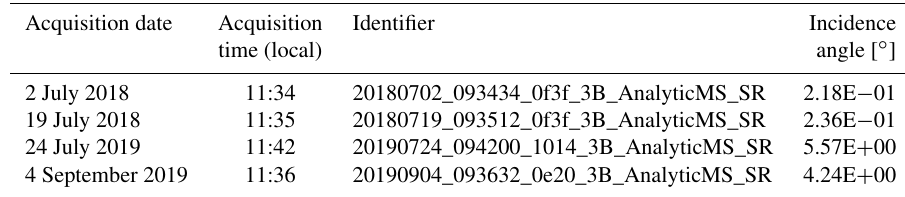
Table 5. PlanetScope Ortho Scene